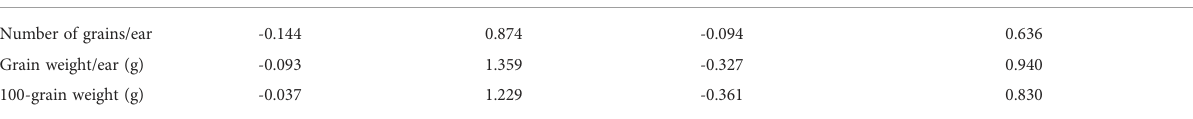
TABLE 6 Direct (Diagonal) and indirect effect of yield components on maize grain yield across two years relative to correlation. Characters Number of grains/ear Grain weight/ear (g) 100-grain weight (g) Correlation with grain yield (Mg ha -1 ) Number of